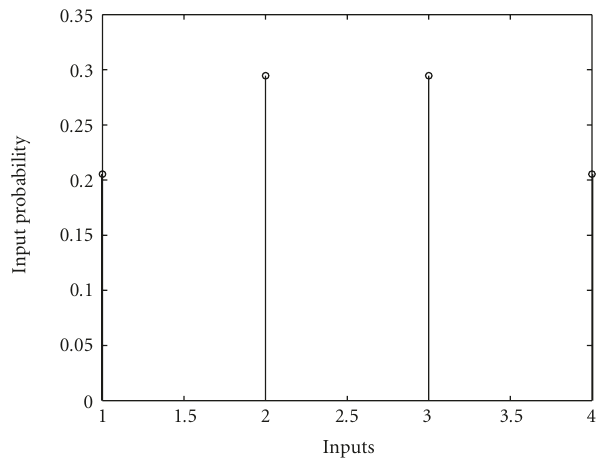
Figure 10: A maximizing input distribution at low SNR for the MIMO channel.